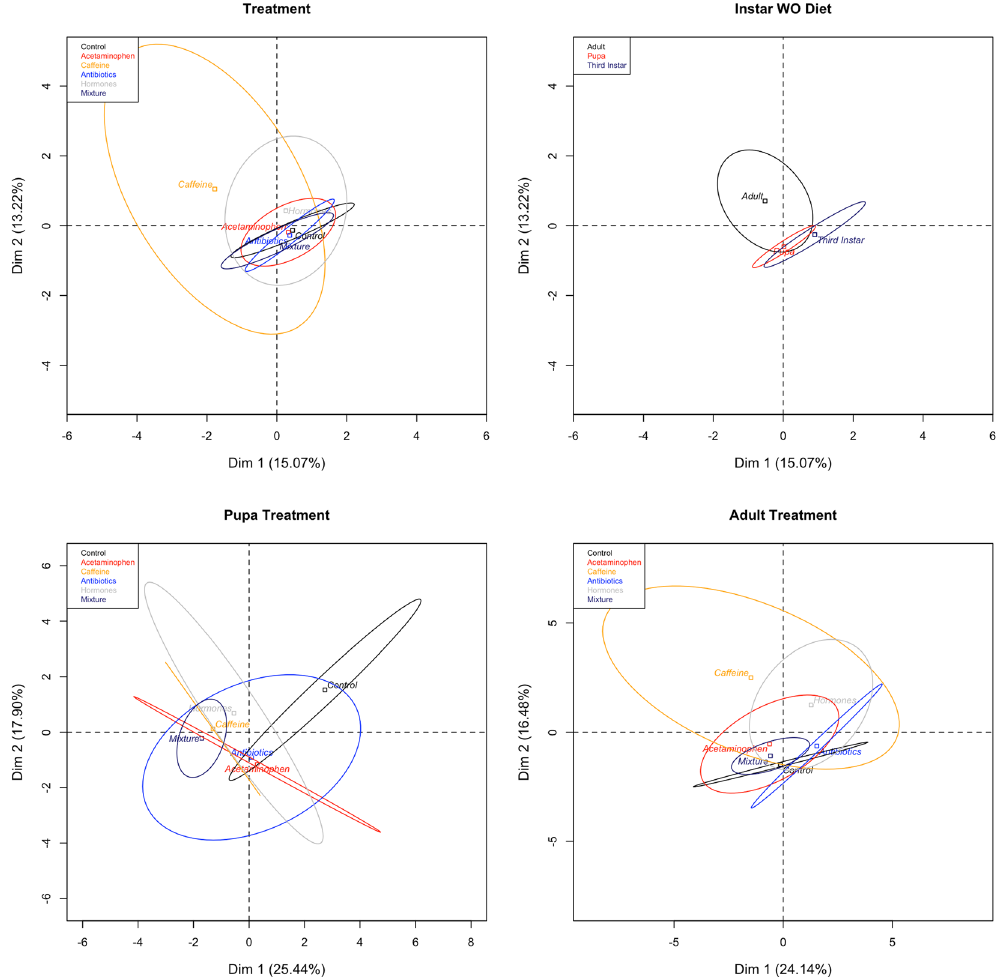
Figure 5. Principal Component Analysis of treatments, life-stage, pupa by treatment, and adult by treatment. Ellipses denote range of individuals around a centroid